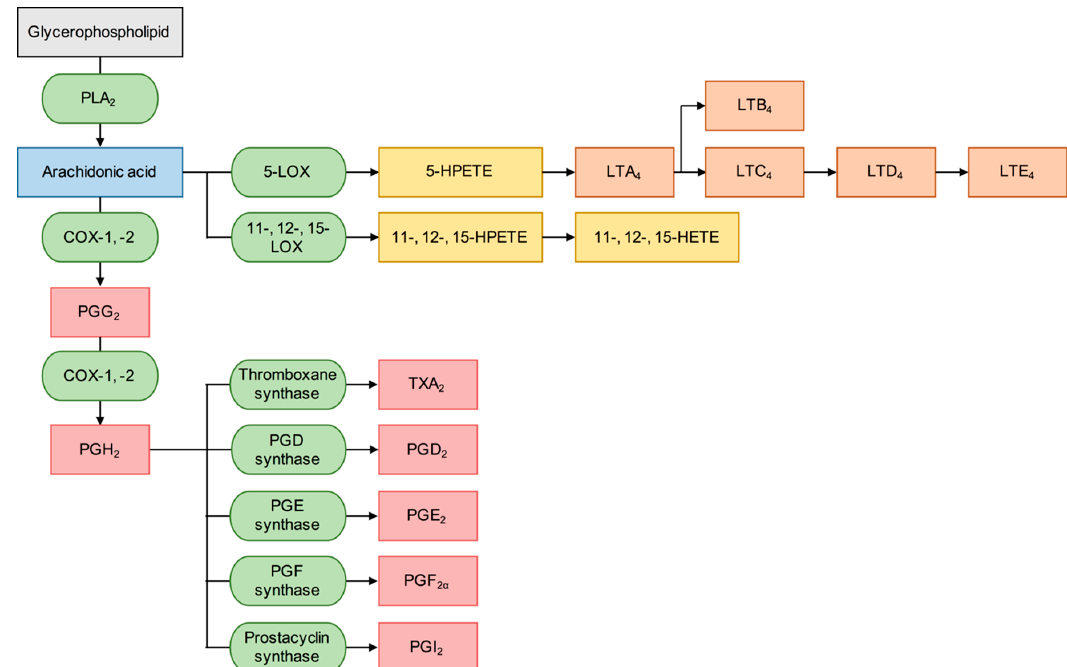
Figure 5. A simplified depiction of the arachidonic acid cascade where the green ellipses represent the enzymes and boxes represent the substrates and products associated with the pathway. The prostaglandins and thromboxane produced in the eicosanoid pathway are metabolites of cyclooxygenases (COXs) and highlighted in pink. The leukotrienes shown in orange are the metabolites of 5-lipoxygenase (5-LOX). Other metabolites produced by LOXs are shown in yellow.